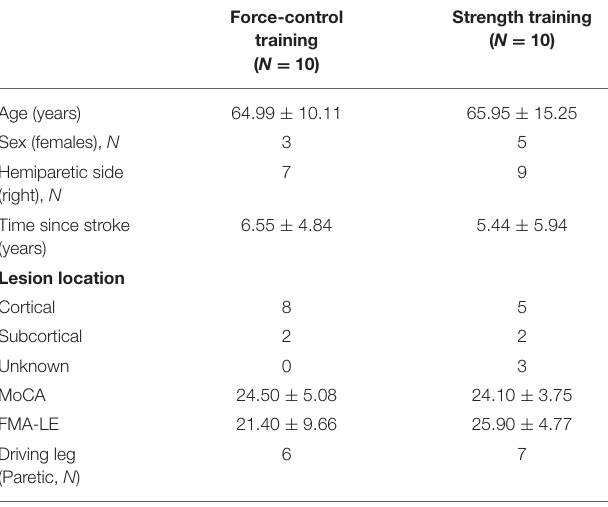
TABLE 1 | Demographics of the participants in each training group (mean ±